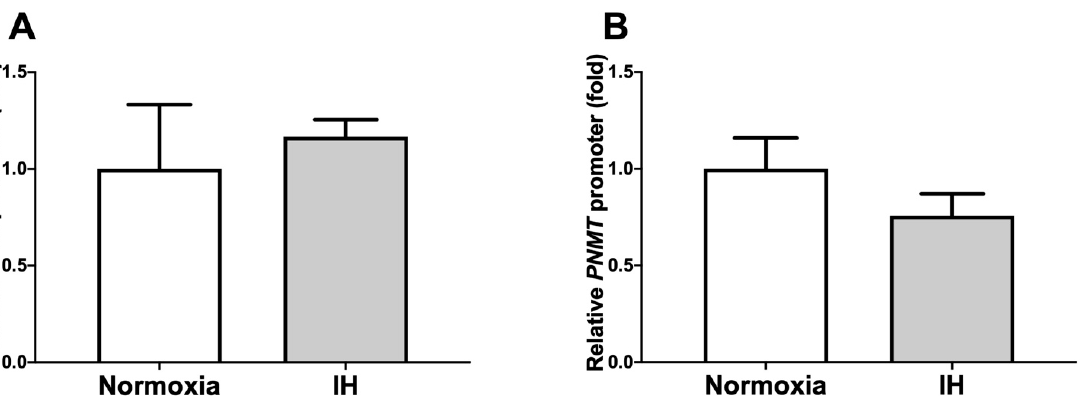
Figure 5. Promoter activities of DBH ( A ) and PNMT ( B ) in human NB-1 neuroblastoma cells. Re-